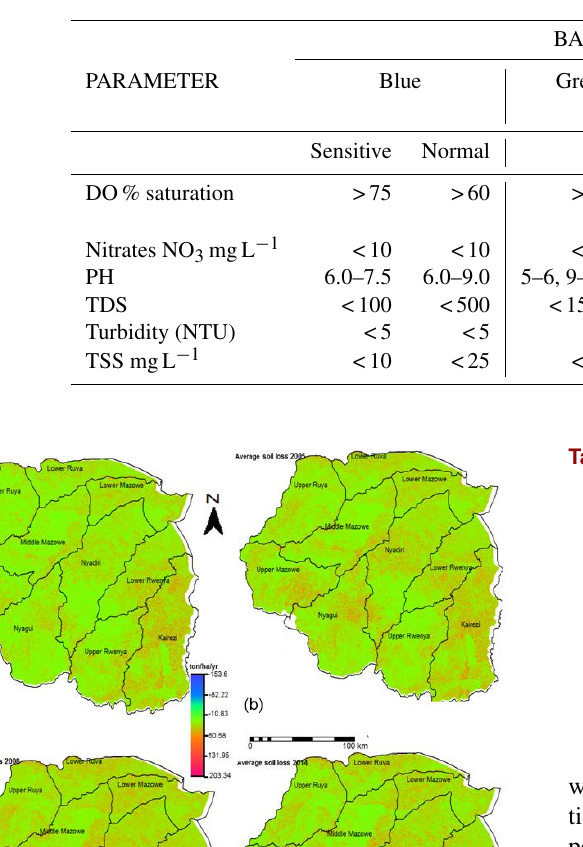
Table 1. Effluent and solid waste disposal regulations.